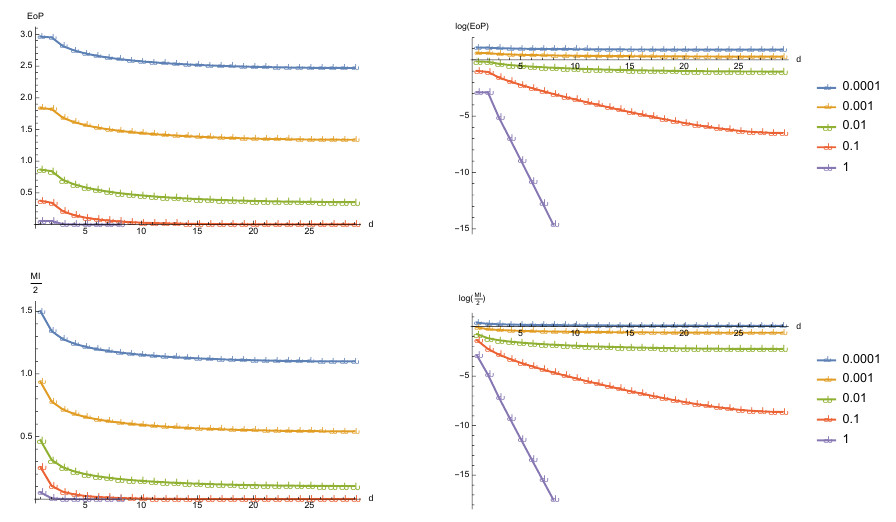
Figure 10 . The plots of EoP (upper graphs) and a half of mutual information I ( A : B ) (lower graphs) as a function of d in the setup of j A j = j B j = 2. The right ones are